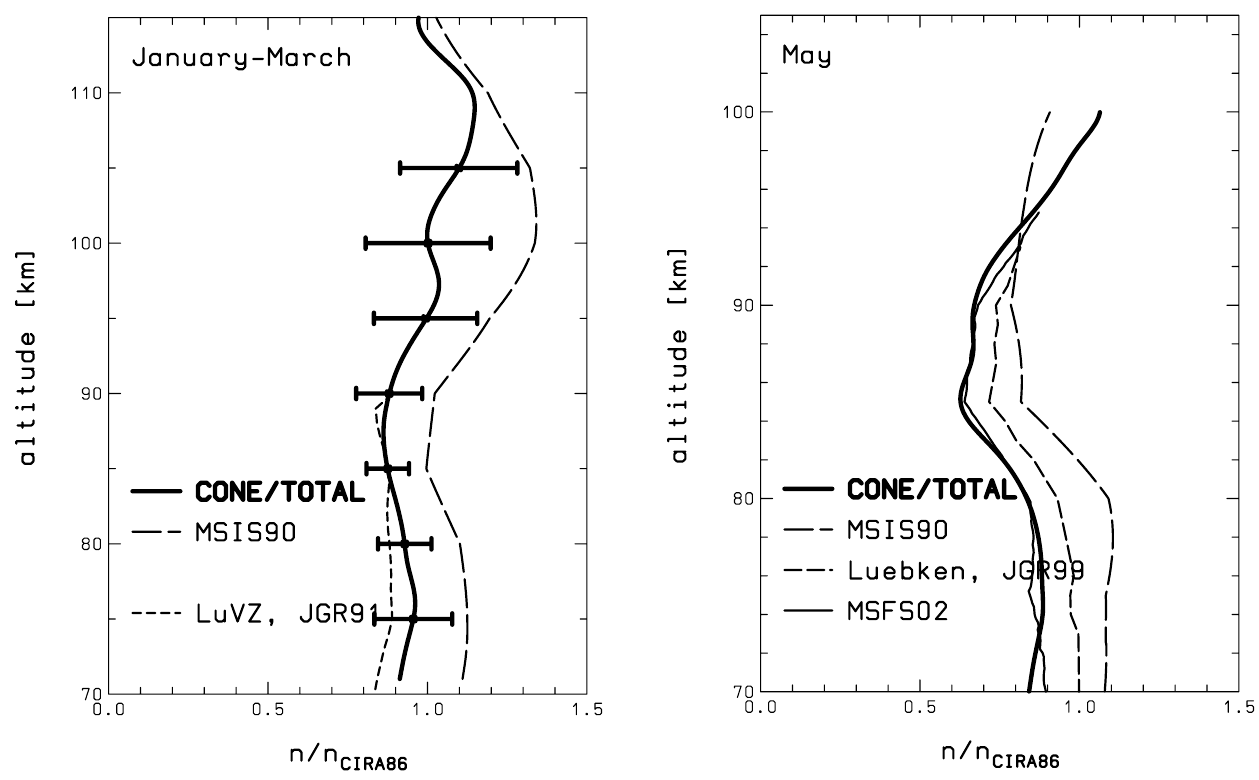
Fig. 12. As for Fig. 9 but for May. The ionization gauge data set comprises only of a single rocket flight in this case. For compar- ison we also show the data of a falling sphere, labeled MSFS02, measured only a few minutes before the sounding rocket